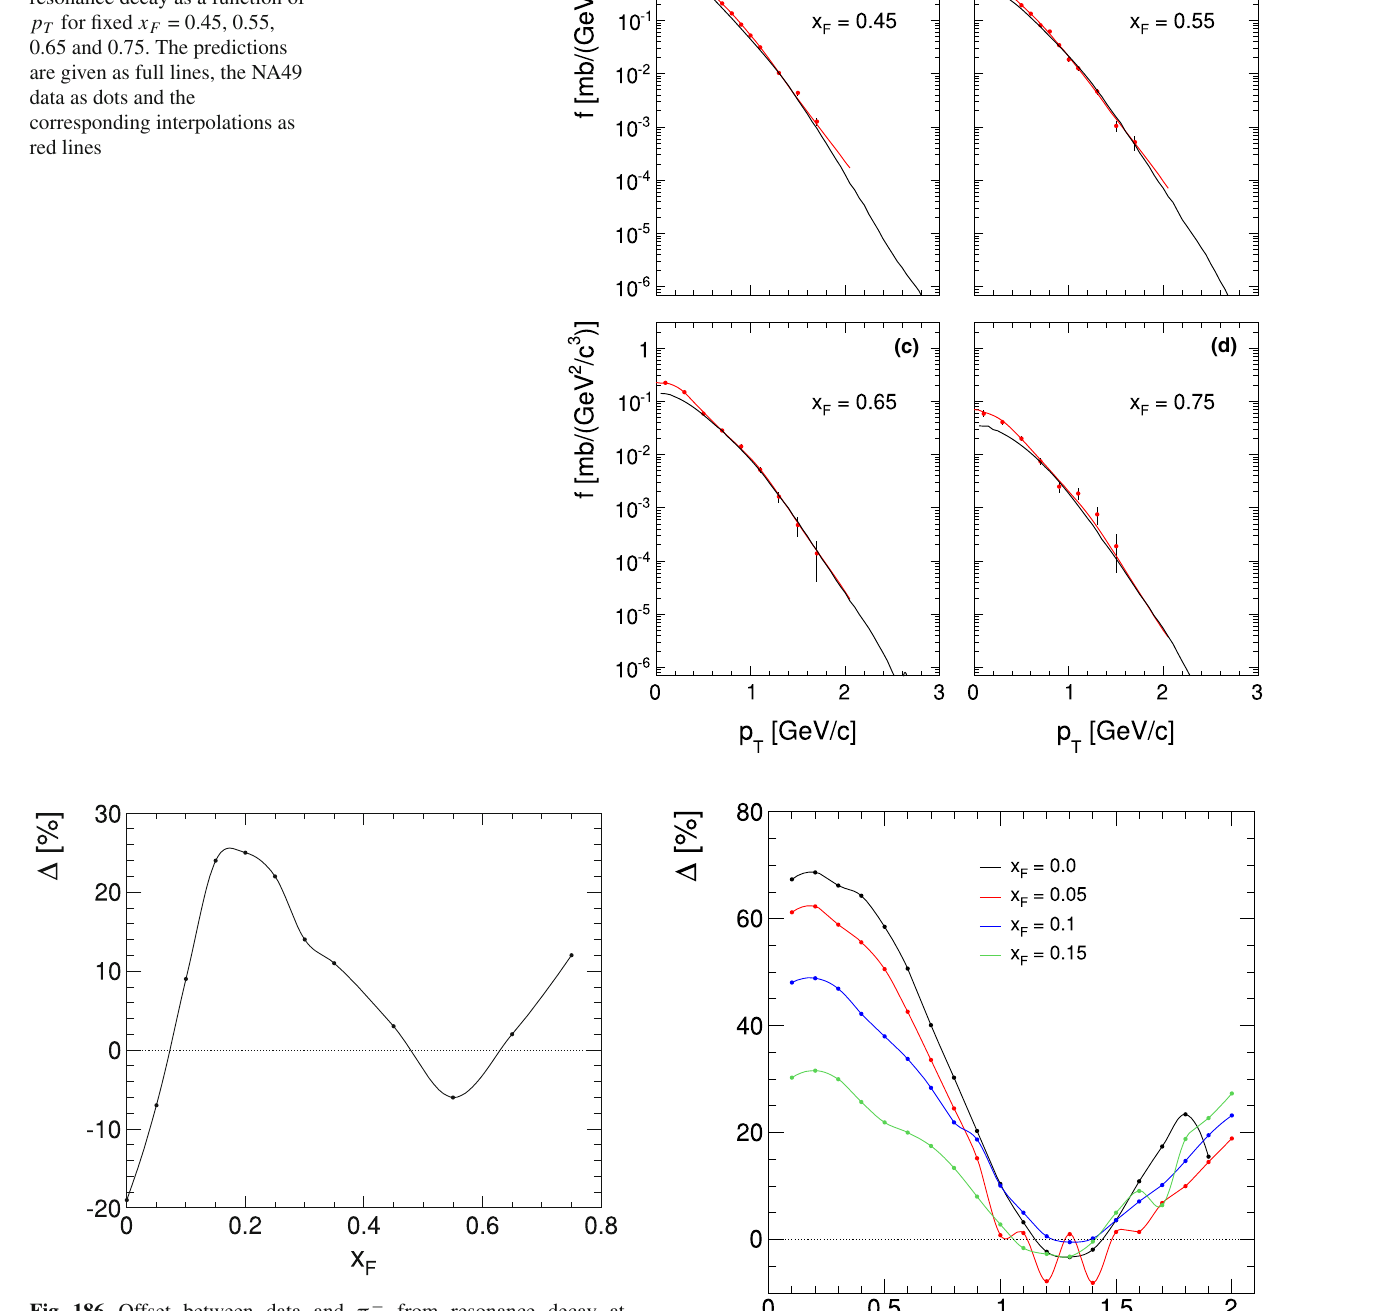
Fig. 186 Offset between data and π − from resonance decay at p T = 1.2 ± 0.3 GeV/c in percent as a function of x F